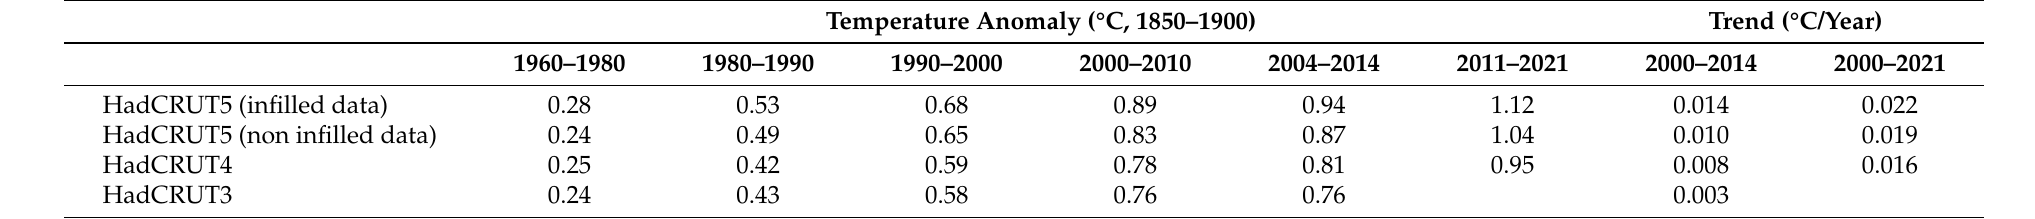
Table A6. Warming means and trends in various periods for HadCRUT3 (1850–2014), HadCRUT4 (1850–2021), HadCRUT5 (non-infilled data, 1850–2021), and HadCRUT5 (filled data, 1850–2021) global surface temperature records. See Figure